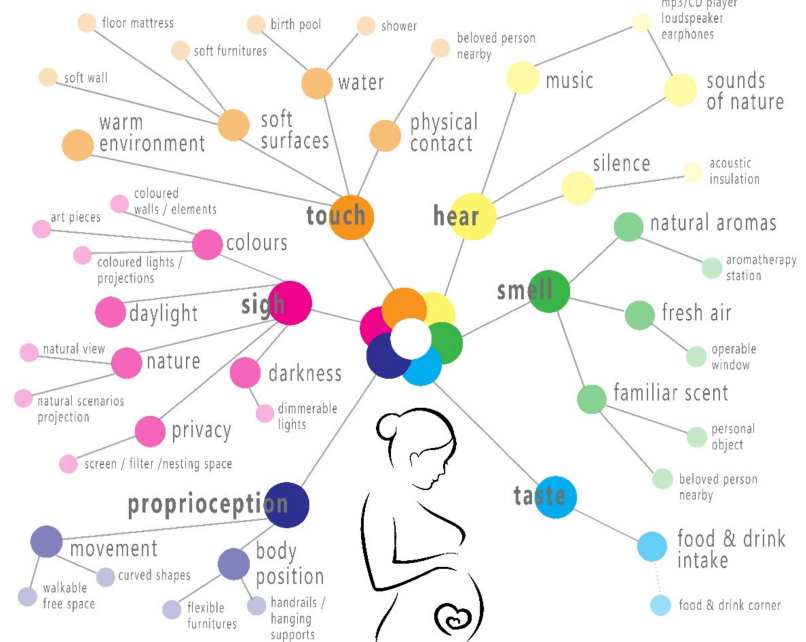
Figure 1. Diagram that represents the “sensory microcosmos” around the childbearing woman.